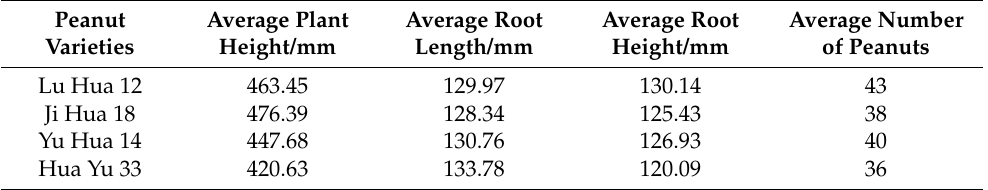
Table 1. Geometric dimensions of